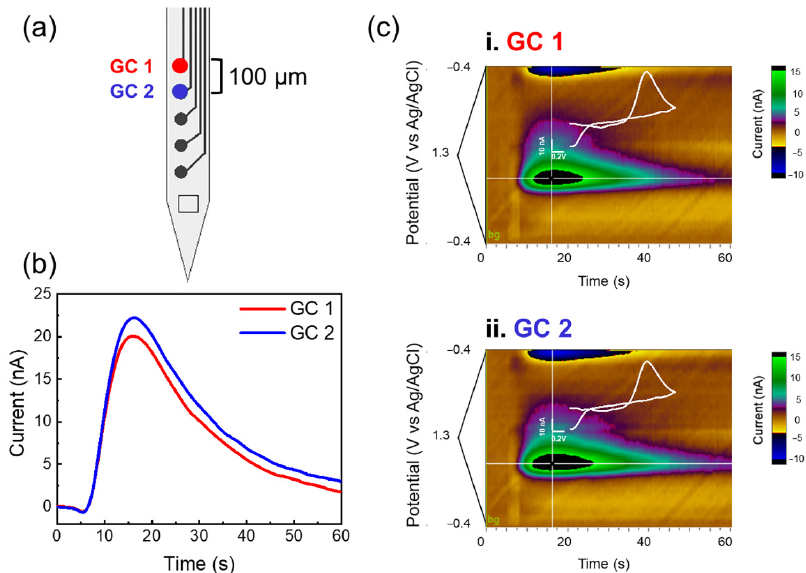
Figure 2. Multichannel detection from 2 adjacent GC microelectrodes (100 µ m interelectrode distance). ( a ) Schematics of a 5-channel GC MEA with the electrode used pointed out. ( b ) Current/time plot of DA released in the dorsal striatum, evoked by electrical stimulation of DA axons in the medial forebrain bundle (MFB), using 2 adjacent GC microelectrodes; ( c ) corresponding color plots. These recordings are obtained after pharmacological manipulations (2 mg/kg raclopride and 20 mg/kg NOM).